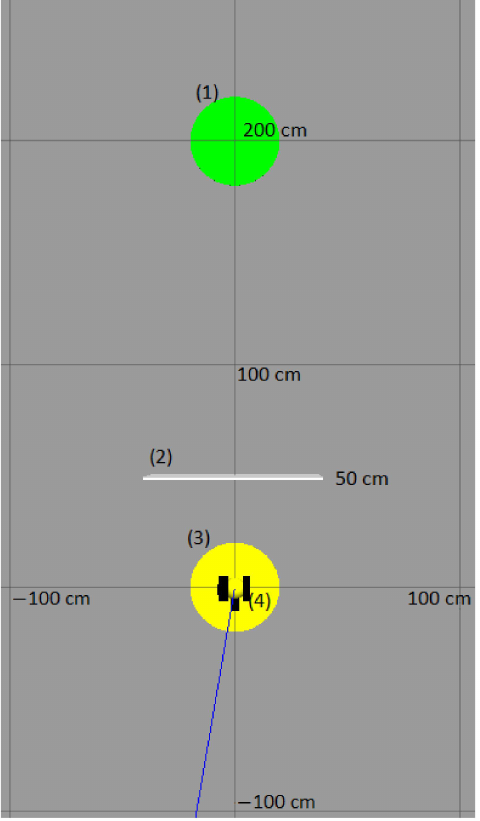
Figure 6. Simulated scenario with one obstacle: (1) goal, (2) obstacle, (3) home, and (4) robot. The real implementation of this scenario is shown in Figure 7.